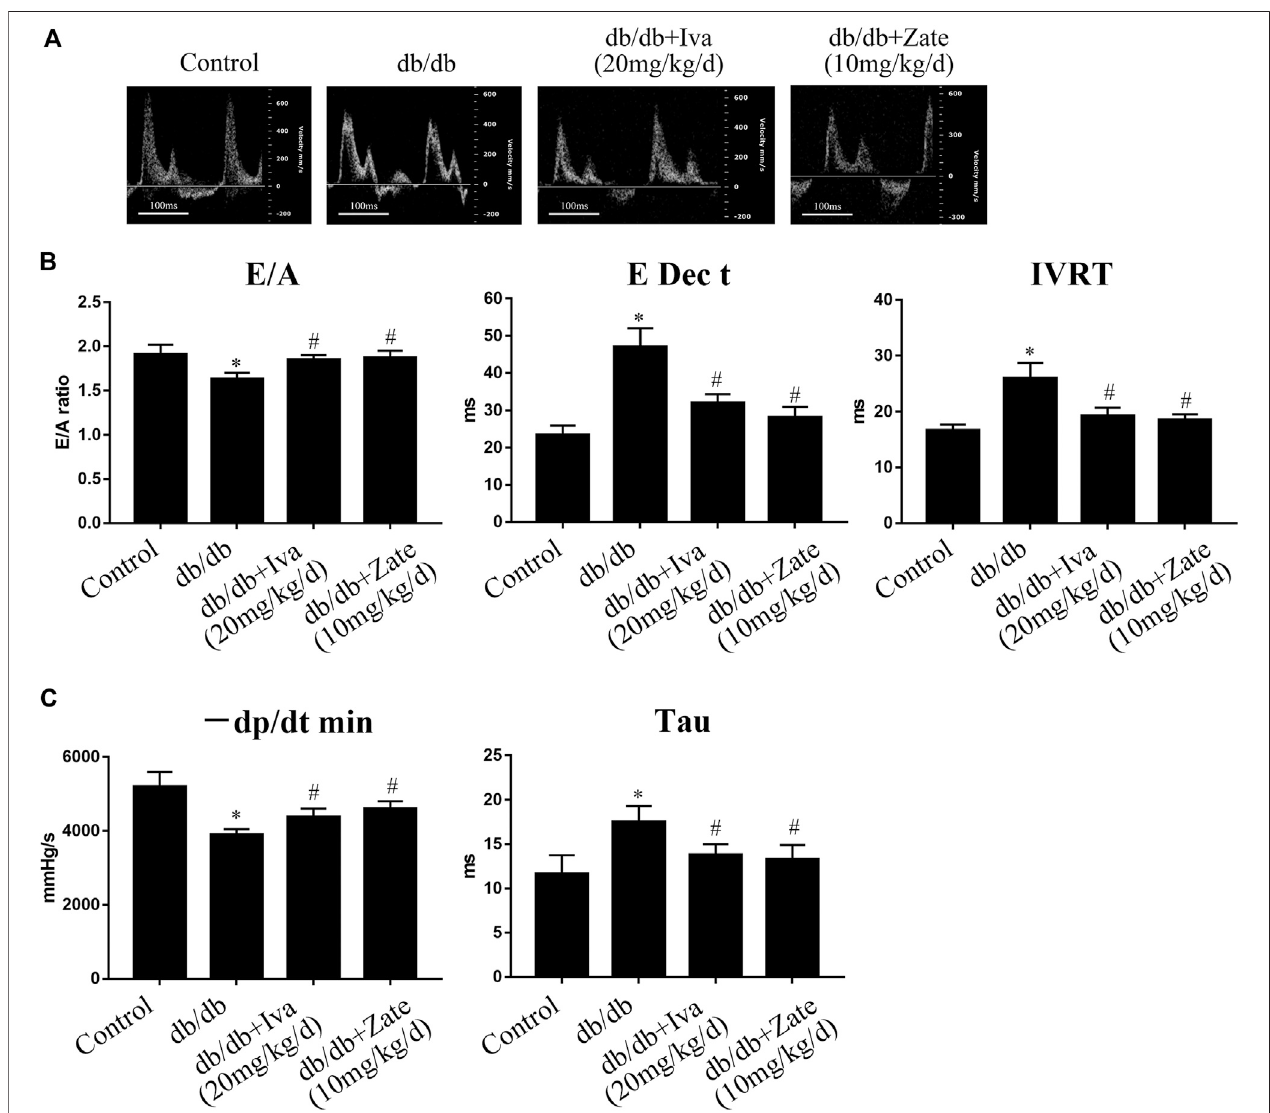
FIGURE8| Ivabradineandzatebradineamelioratediabetes-inducedcardiacdiastolicdysfunction(DD) (A) Micewereadministeredivabradineorzatebradineatthe indicated doses and echo-Doppler traces for the transmitral fl ow were recorded (B) Mice were treated as described in (A) and transmitral pulsed-wave Doppler measurements of E/A, E Dec t, and IVRT were obtained (C) Mice were treated as described in (A) and the hemodynamic parameters − dP/dt min and Tau were measured. The columns show the differences in left ventricular DD and hemodynamic parameters. Data are presented as mean ± SEM ( n (cid:2) 6). p -values were calculated using one-way ANOVA with Tukey multiple comparison test. * p < 0.05, compared to the Control group; # p < 0.05, compared to the db/db mouse group.